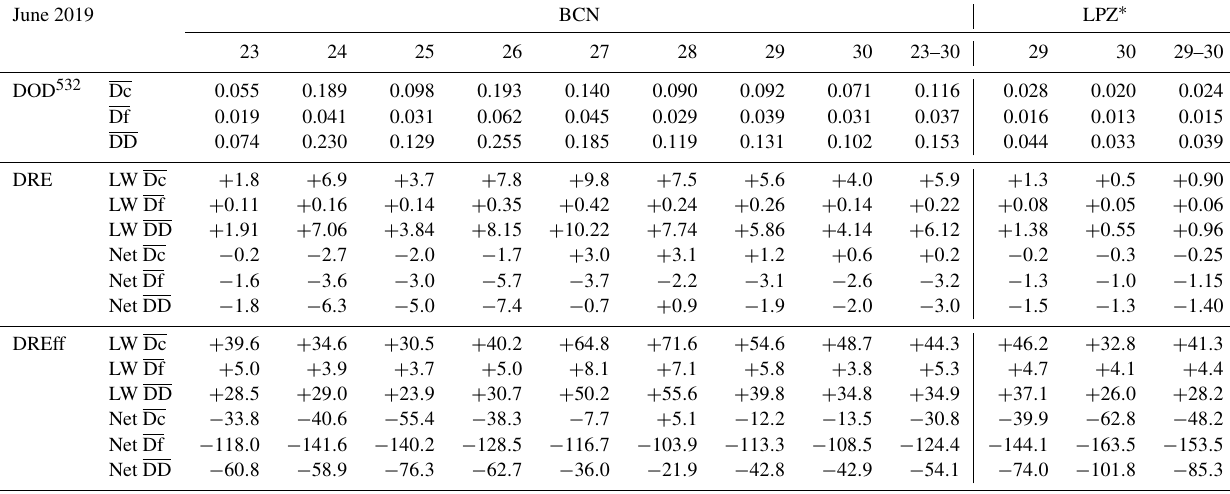
Table 1. Daily DRE LW and DRE NET (Wm − 2 ) and DREff (Wm − 2 τ − 1 ) at SRF produced by Dc, Df and DD particles in BCN and LPZ. X indicates daily averages. The daily DOD at 532nm, DOD 532 , is also included. Df and DD DRE LW and the 29–30 June mean DRE in LPZ are given with a precision of two digits.